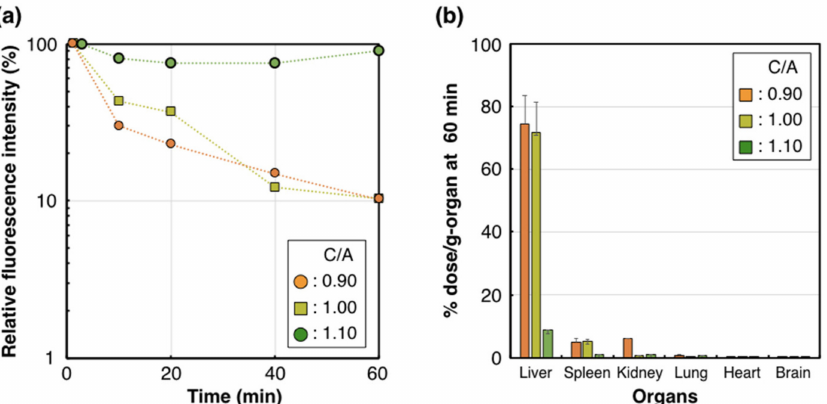
Figure 3. Pharmacokinetic profile of the Cy5-PIC/m with a C/A of 0.90, 1.00 and 1.10. ( a ) Plasma retention of Cy5-PIC/m (orange circle, yellow square and green circle indicate 0.90, 1.00 and 1.10, respectively) observed by IVRT-CLSM. ( b ) Accumulation of Cy5-PIC/m in the liver at 60 min. n = 4. Data are shown as means ± SEM.